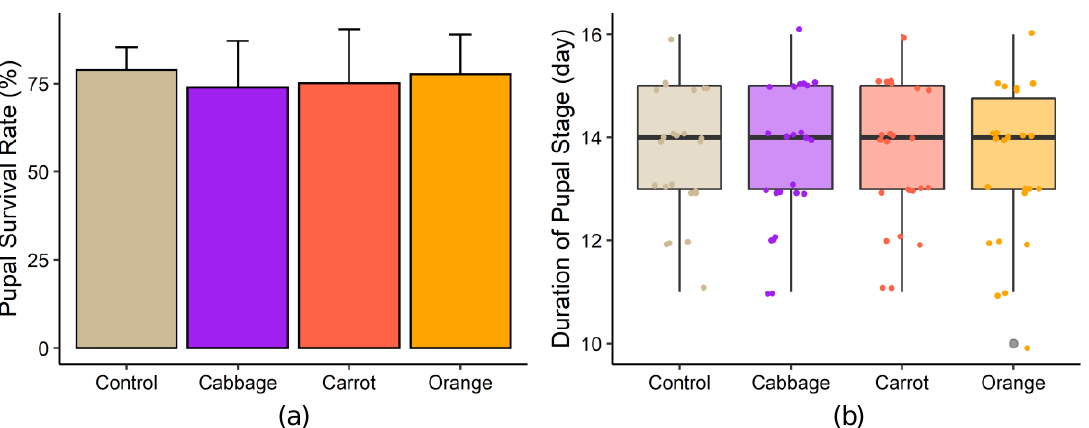
Figure 2. ( a ) Pupal survival rate and ( b ) pupa-to-beetle development time of mealworms fed on different diets.